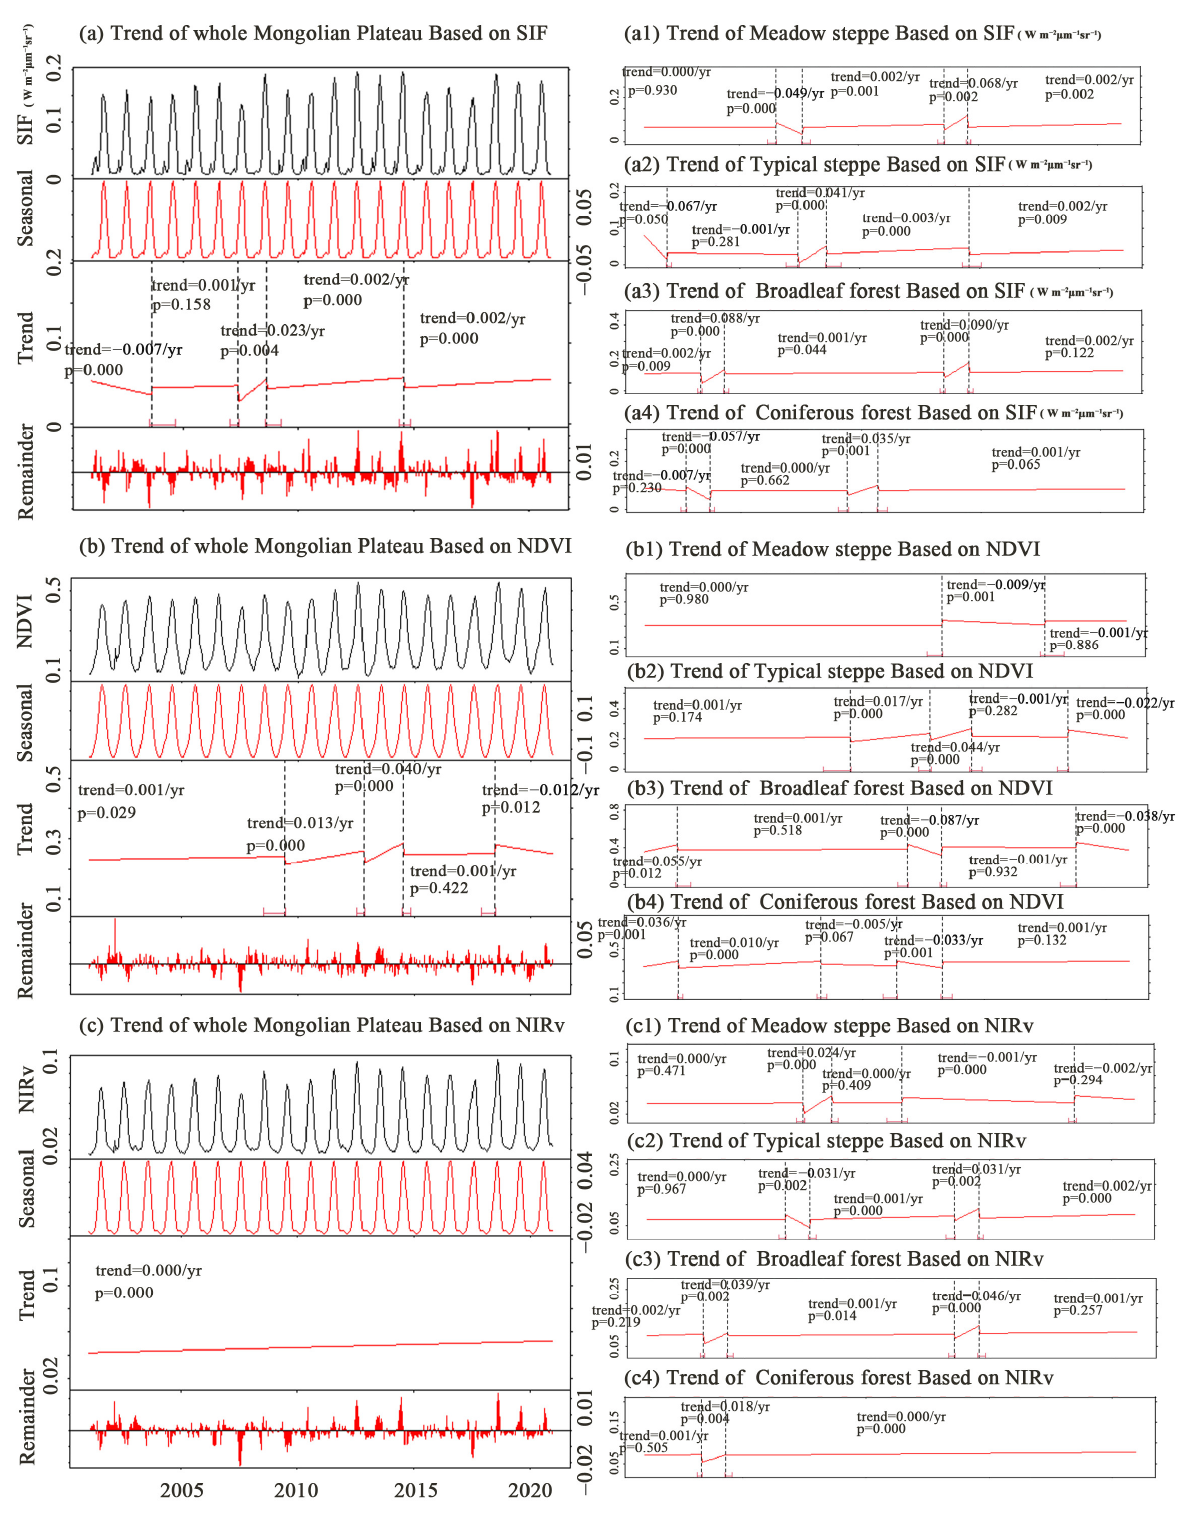
Figure 2. Vegetation trends and breakpoints retrieved from three types of remote-sensing data: ( a – c ) Mongolian Plateau results based on SIF, NDVI and NIRv; ( a1 , b1 , c1 ) meadow-steppe results based on SIF, NDVI and NIRv; ( a2 , b2 , c2 ) typical-steppe results based on SIF, NDVI and NIRv; ( a3 , b3 , c3 ) broadleaf-forest results based on SIF and NDVI; ( a4 , b4 , c4 ) coniferous-forest results based on SIF, NDVI and